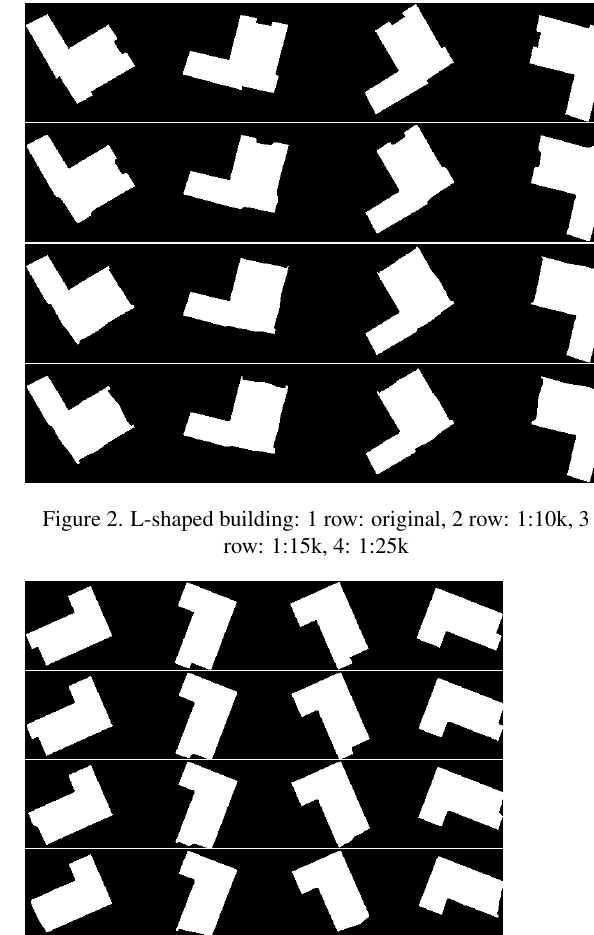
Figure 3. L-shaped building: 1 row: original, 2 row: 1:10k, 3 row: 1:15k, 4: 1:25k